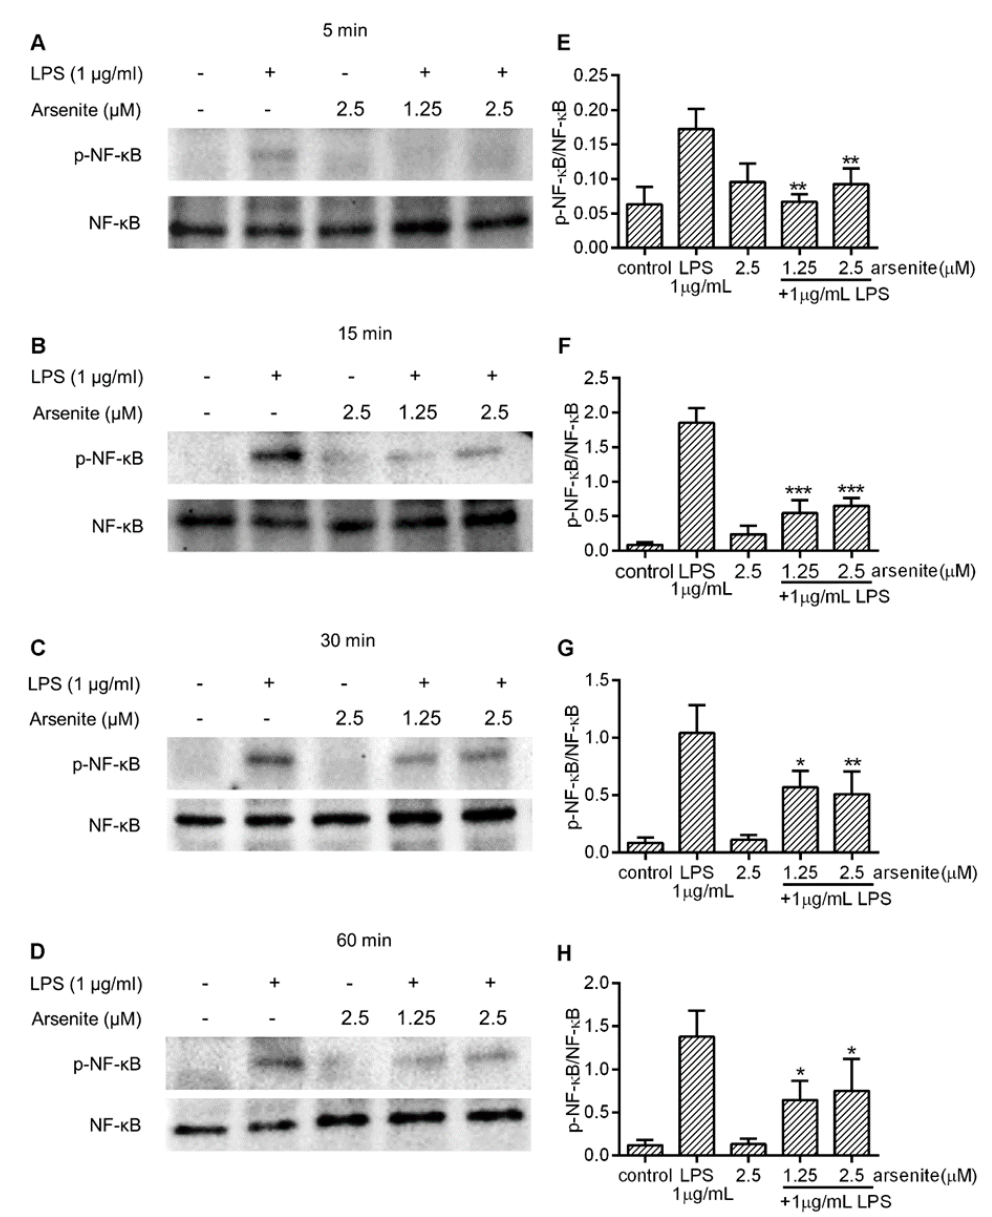
Figure 4. The effect of cell stress on NF- κ B phosphorylation in LPS-stimulated 030D cells. The 030D cells were incubated with different concentrations (1.25 and 2.5 µM) of arsenite, or without, for 16 h, after which the cells were exposed to LPS and harvested at 5 min ( A , E ), 15 min ( B , F ), 30 min ( C , G ) and 60 min ( D , H ). Whole cell lysates were extracted and analyzed by Western Blotting. Control: untreated cells. Phosphorylated NF- κ B and total NF- κ B were detected with rabbit monoclonal anti-phospho-NF- κ B p65 and HRP-labeled swine-anti rabbit IgG, and mouse monoclonal anti- NF- κ B p65 and HRP-labeled rabbit anti-mouse IgG, respectively. The densitometry of the protein bands was scanned and quantitated with Image lab TM software 6.0.1 ( E – H ). The total NF- κ B levels were used as an internal control. Data are shown as the mean ± SD and are representative of three independent experiments. * p < 0.05, ** p < 0.01, and *** p < 0.001, vs. LPS alone group.